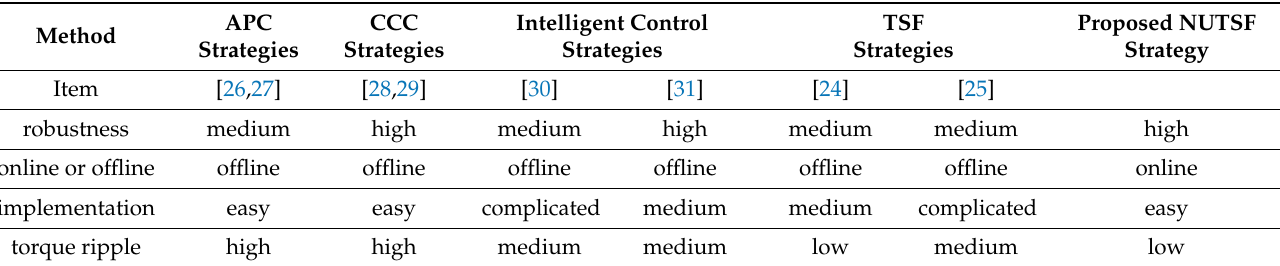
Table 1. Comparison of torque ripple reduction methods.